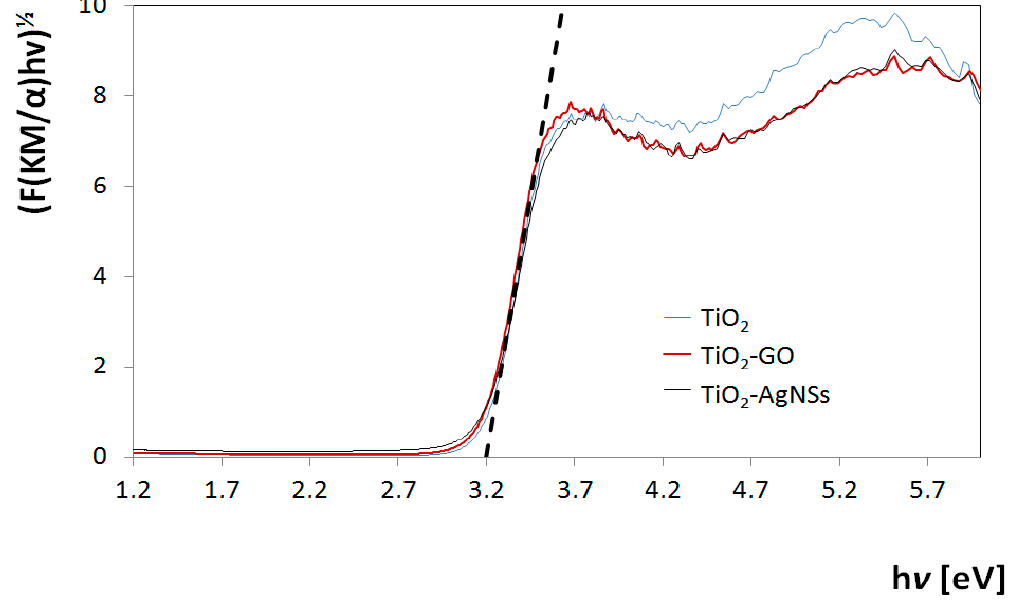
Figure 7. Tauc plot for TiO 2 (blue line), TiO 2 -GO (red line), TiO 2 -GO-AgNSs (dark grey line).